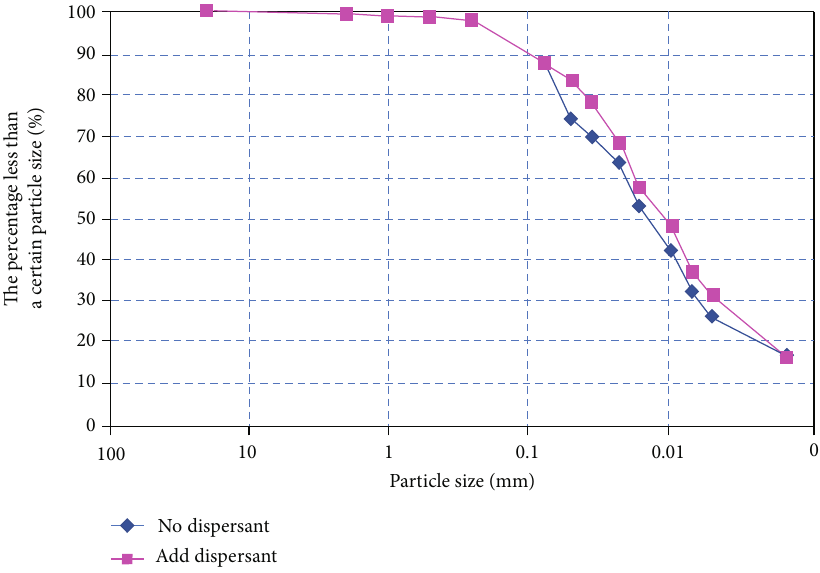
Figure 6: The particle size distribution curve of sliding zone